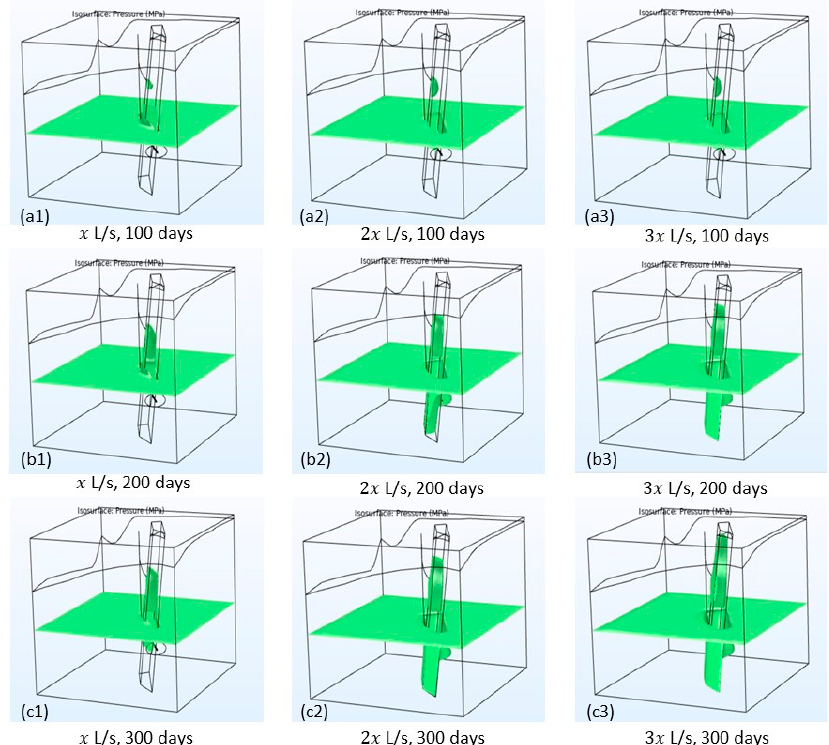
Figure 11. Pressure plume development for three different injection rates at three different times. The iso-surfaces are plotted for 3.5𝑥 MPa. During the 300 days, the temperature changes are limited near the injection well. Therefore, to examine the effects of different flow rates on the temperature, temperature changes alongside the open hole section of the injection well and inside the fault zone are being considered, which is very close to the wellbore in Figure 12 for different flow rates. On the horizontal axis, 0 m shows the top point of the open hole section of the injection well, and 300 m shows the bottom point of this section. Initially (0 days in the graphs), the temperature distribution follows up the temperature gradient of the system. As time goes on, the cold front propagates to the deeper zones of the reservoir. An increase in the flow rate increase the speed of the temperature front propagation in the farther regions, and it shows that the heat transfer process is mainly controlled by the convective mechanism. The possibility of higher fluid injection should be examined through the techno-economic aspects. The increasing flow rate will increase the heat extraction rate at early times. On the other hand, it increases the possibility of seismic events and early breakthrough time [25].